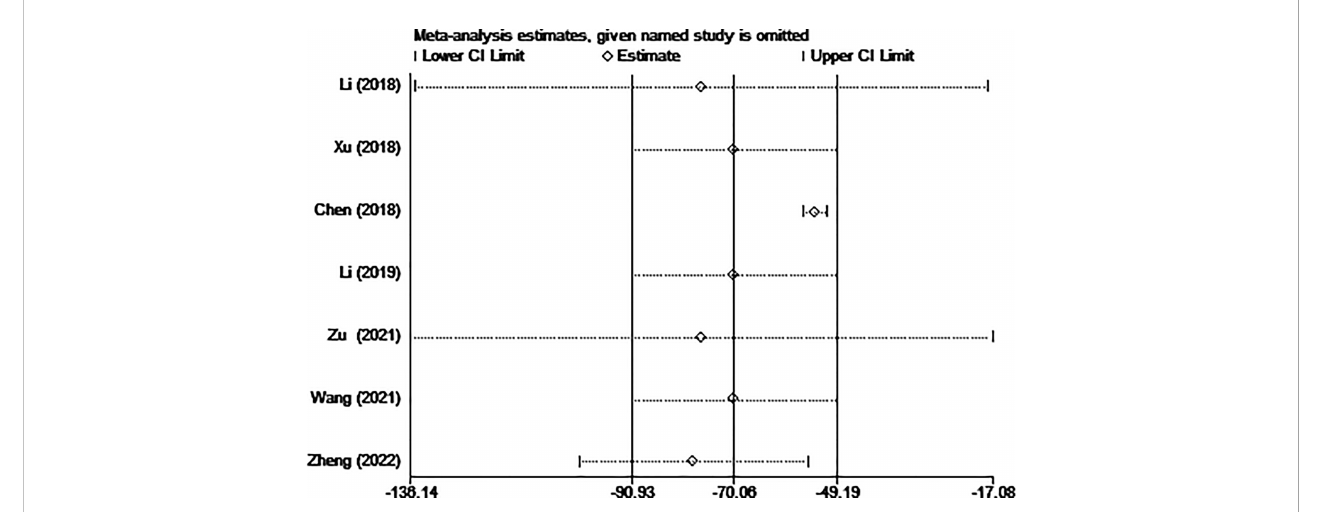
FIGURE 12 Sensitivity analysis of hospitalization costs for comparing MWA with surgery in patient with PTMC. MWA, microwave ablation, PTMC, papillary thyroid microcarcinoma.